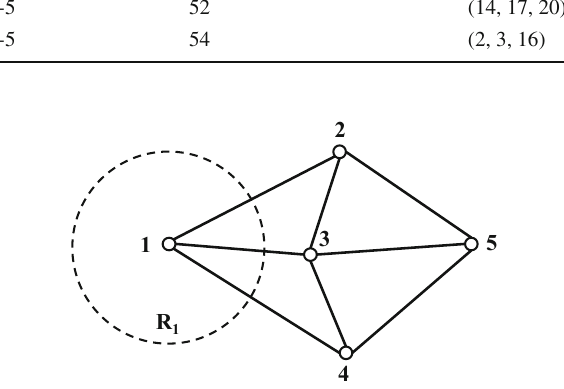
Fig. 7 The ripple spreading motion at t = 1